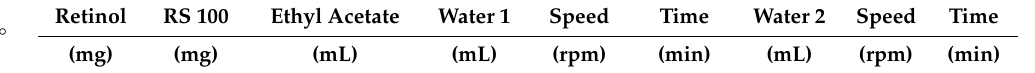
Table 2. Compositions of the prepared nanoparticles.